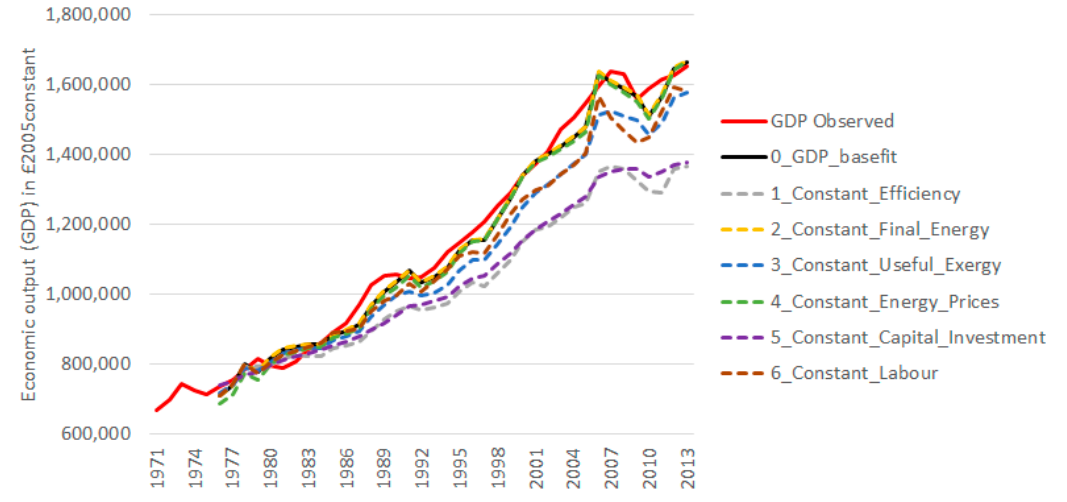
Figure 3. Economic output GDP under counterfactual Figure 3 . Economic output GDP under counterfactual simulations.